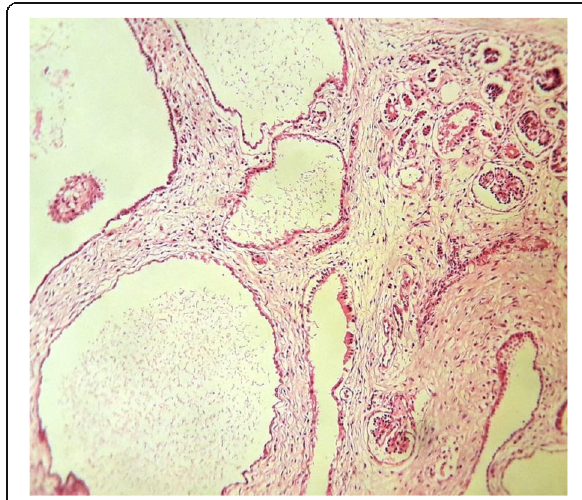
Fig. 5 Photomicrograph from section taken from the right kidney shows fetal glomeruli & multiple cystically dilated tubules (4 X). Sections studied from the left kidney also showed similar features